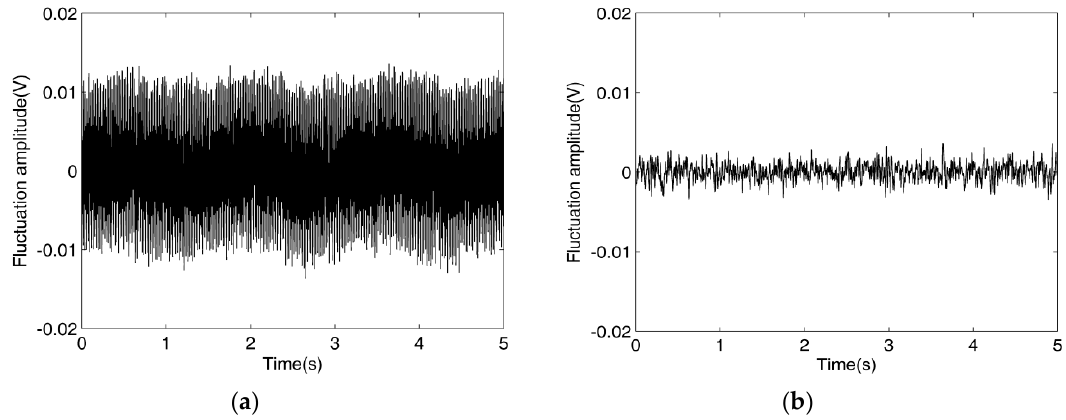
Figure 9. Output signals: ( a ) Supplementary C 4 D with 3.0 mm i.d.; ( b ) New C 4 D sensor with 3.0 mm